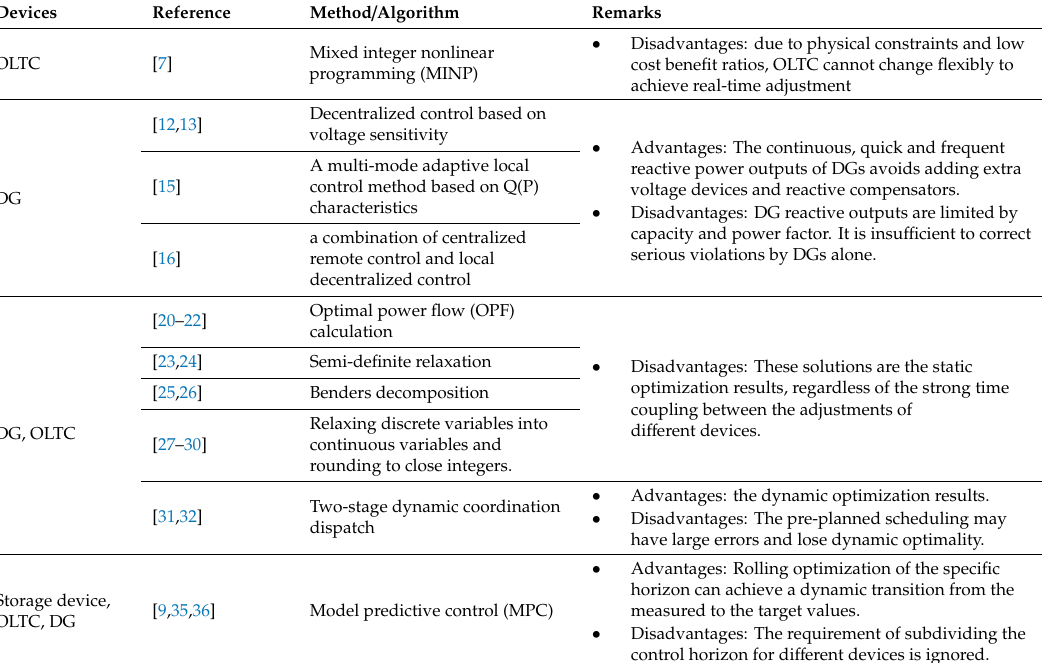
Table 1. Summary of the literature related to ADN optimization